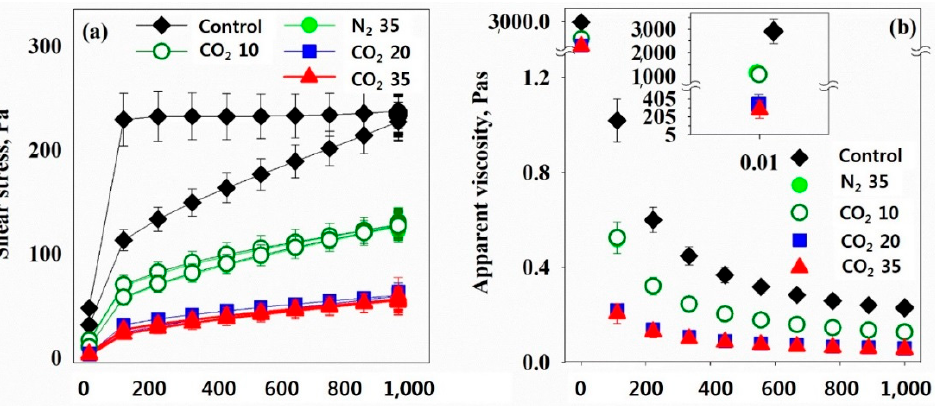
Figure 7. Hysteresis loop and viscosity of various sludge samples; ( a ) relationship between the applied stress and shear rate response of the control and the HbQF-treated sludge under various test conditions; ( b ) viscosity of the sludge.